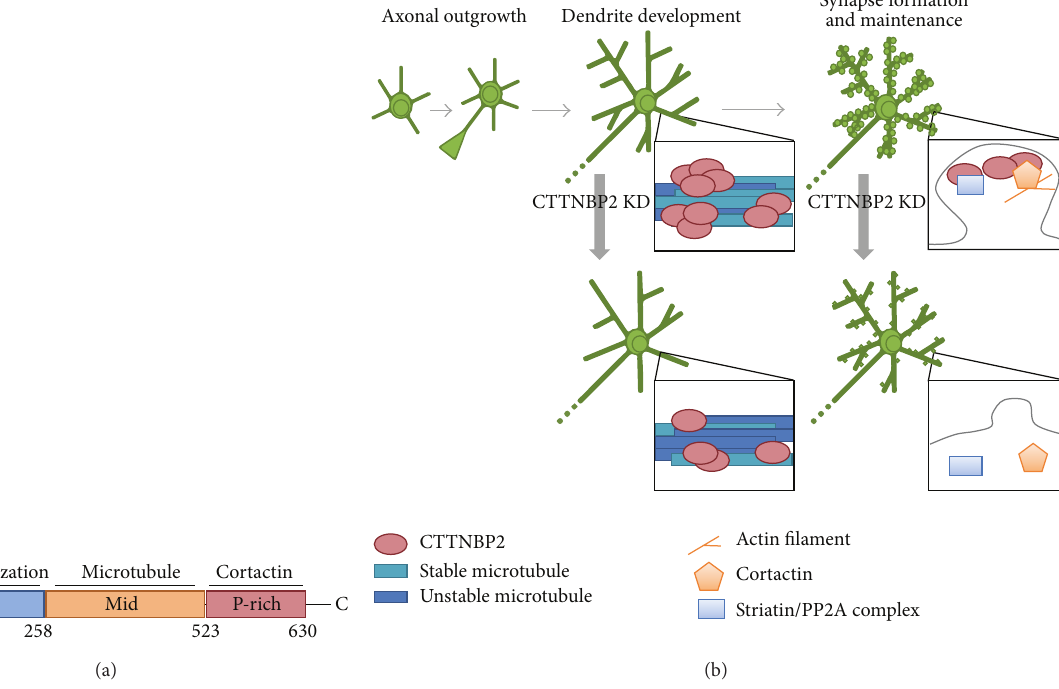
Figure 4: CTTNBP2 and neuronal differentiation. (a) Schematic domain structure and CTTNBP2-S-interacting proteins. CC, coiled-coil domain; Mid, middle region; P-rich, proline-rich domain. (b) The function of CTTNBP2-S in neuronal morphogenesis. CTTNBP2-S controls microtubule stability in the dendritic shafts and cortactin mobility in dendritic spines. Upon CTTNBP2 knockdown during dendritic extension, dendritic complexity decreases. During synaptogenesis, CTTNBP2-S helps maintain cortactin in dendritic spines and promotes dendritic spine formation and